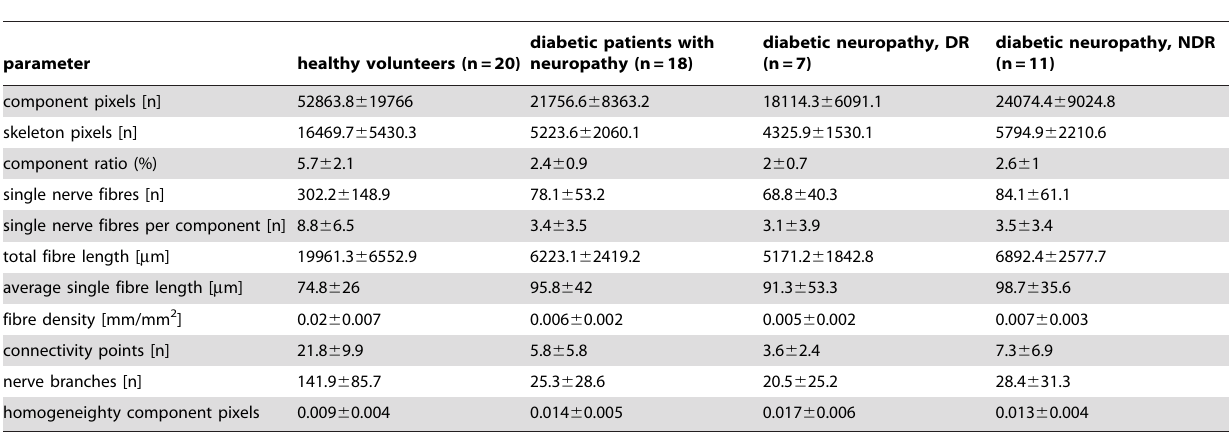
Table 4. Results of automatic quantification of SBP structures (data presented as mean 6